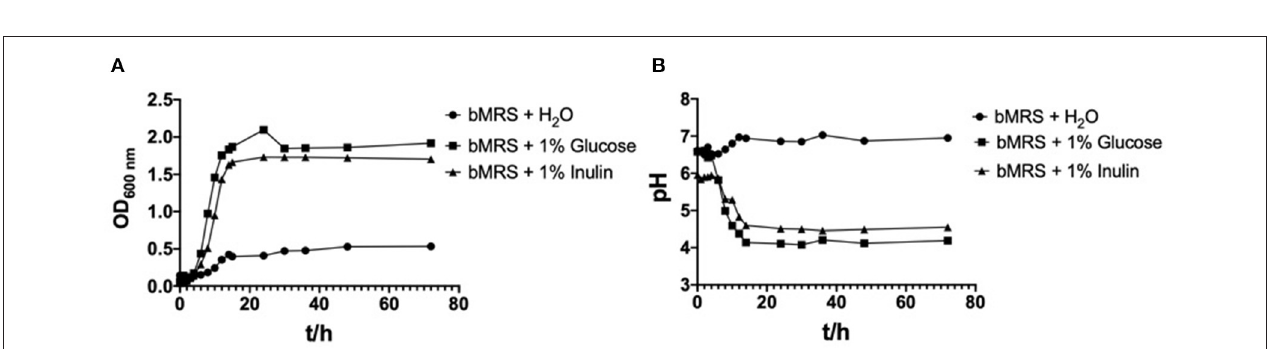
FIGURE 1 | Phylogenetic tree of strain YT170 and related species constructed on the basis of 16S rRNA gene sequences using the neighbor-joining method. The numbers next to the branches indicate percentage values for 1,000 bootstrap replicates. GenBank accession numbers for the sequences are shown in parentheses. The scale bar represents 0.010 substitutions per site.